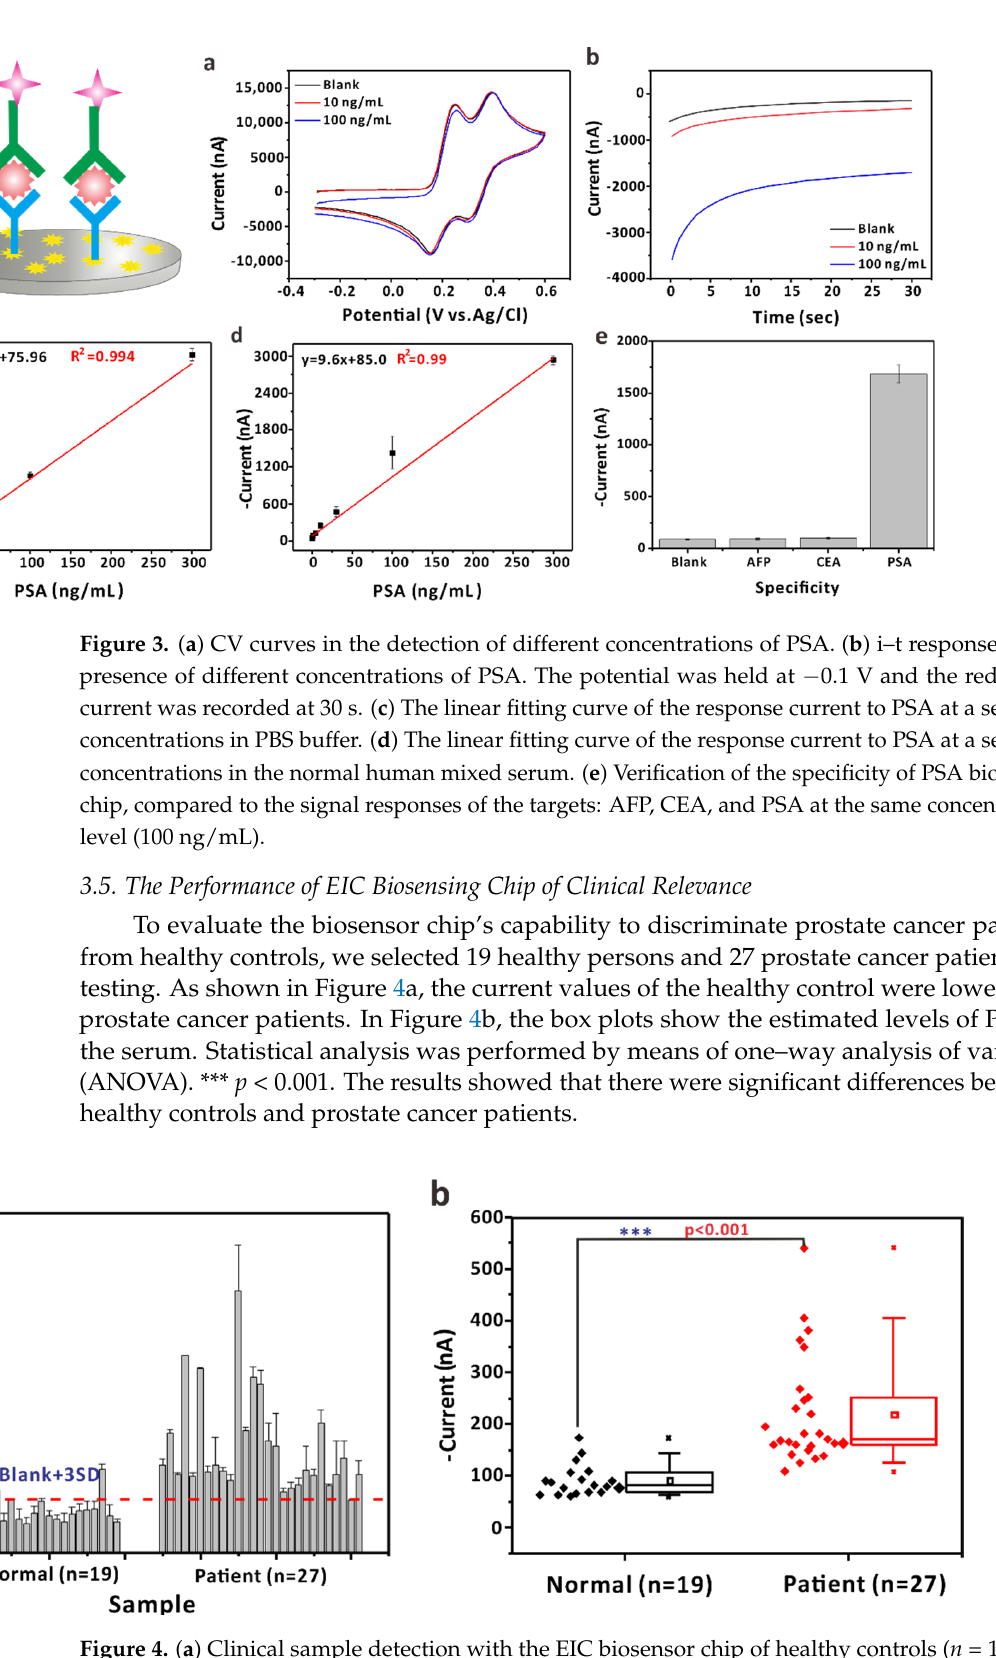
6 of 9 Figure 2. ( a ) Optimization of the coating concentration of the PSA capture antibody. ( b ) Optimization of the chromatographic reaction time of the EIC system for PSA detection. 3.4. Evaluation Performance of EIC Biosensing Chip of PSA Based on the Au NF s Interface We employed the EIC biosensing chip to detect the prostate cancer biomarker (PSA) by modifying the SPCE/Au NFs with the recognition element that specifically captured each biomarker. Under the optimized conditions, we evaluated the analytical performance of PSA. As shown in Figure 3a, two pairs of distinct redox peaks were observed, indicating that potentials lower than 0.05 V should be suitable for measurements. We chose − 0.1 V for the following i–t measurements (Figure 3b). The standard PSA solution was diluted to different concentrations from 0 to 300 ng/mL. The reduction current generated by the HRP catalyzed substrate TMB increased with the